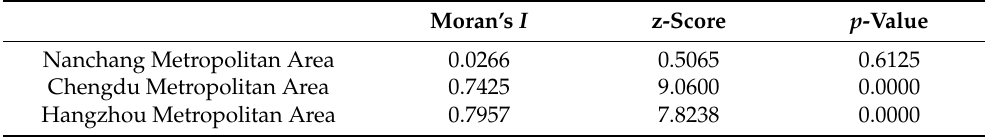
Table 4. Global Moran’s I of LUCE sources. Table 5. Global Moran’s I of LUCE